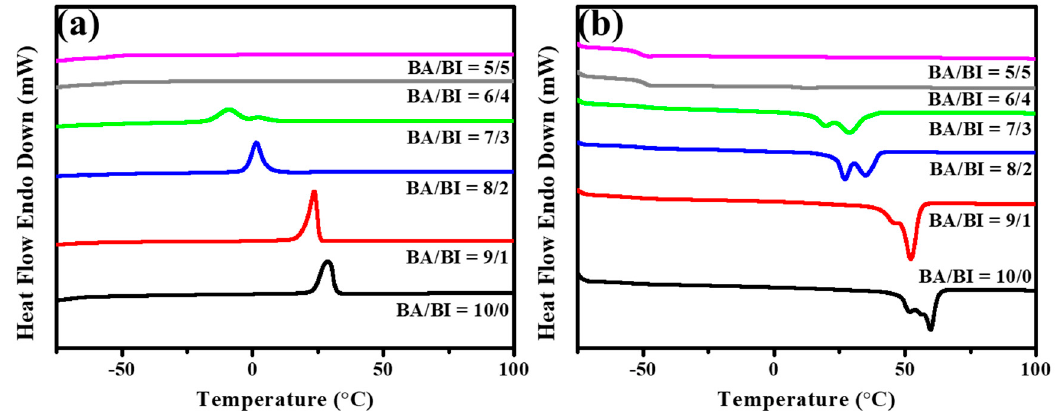
Figure 2. FT-IR spectra of PBABI copolyesters with different BA/BI ratios.